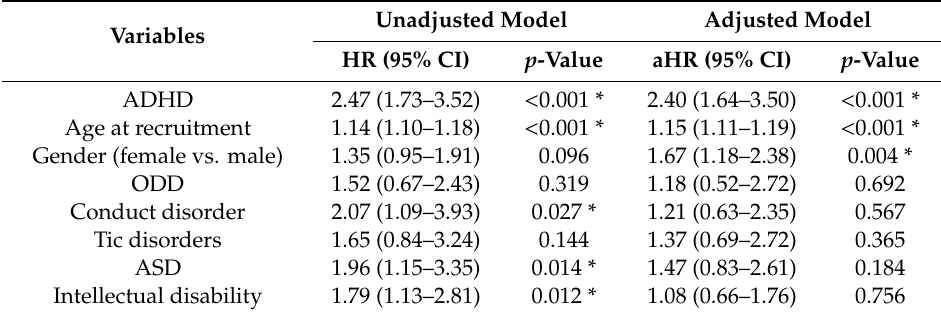
Table 2. Cox’s proportional models for the risk of diagnosis with adrenal gland dysfunction among youths in